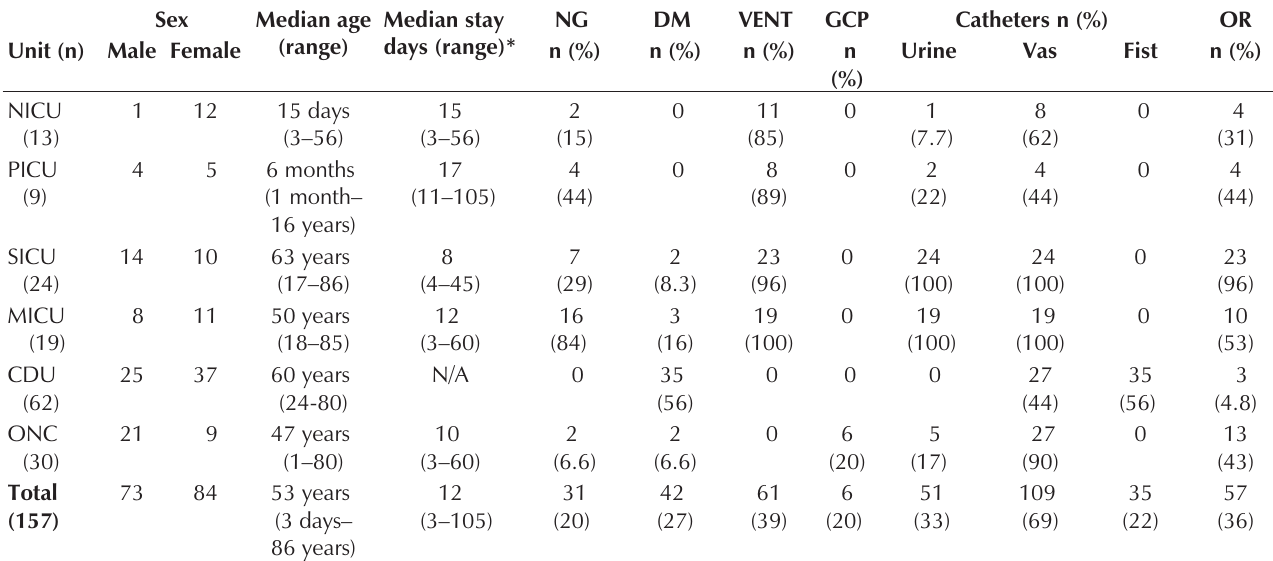
Characteristics of patient population screened